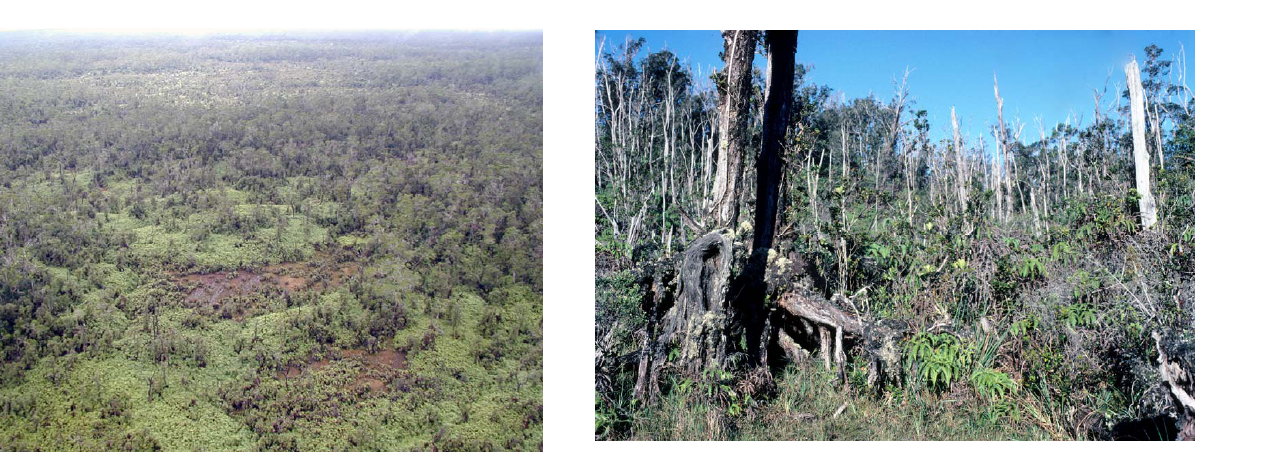
Fig. 13b. Gap-formation dieback north of Wailuku stream at 1200 m (4,000 ft.) elevation. 670